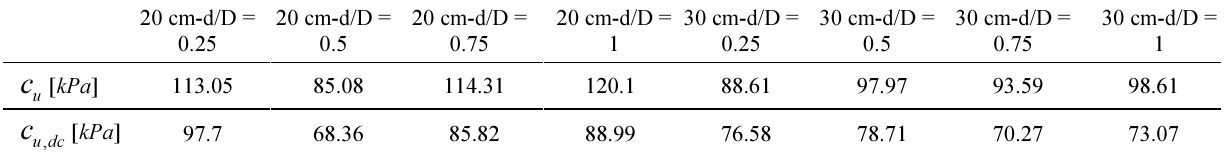
Table 7. Undrained shear strengths calculated analytically using bearing capacity formula